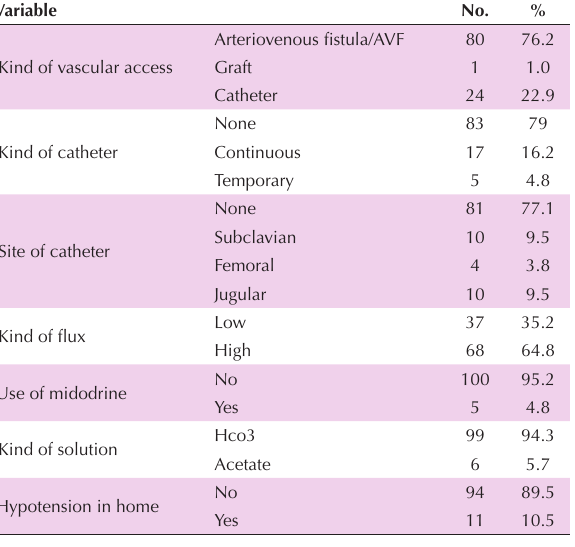
Table 4. Dialysis-related factors in the patients undergoing hemodialysis Variable No. Kind of vascular access